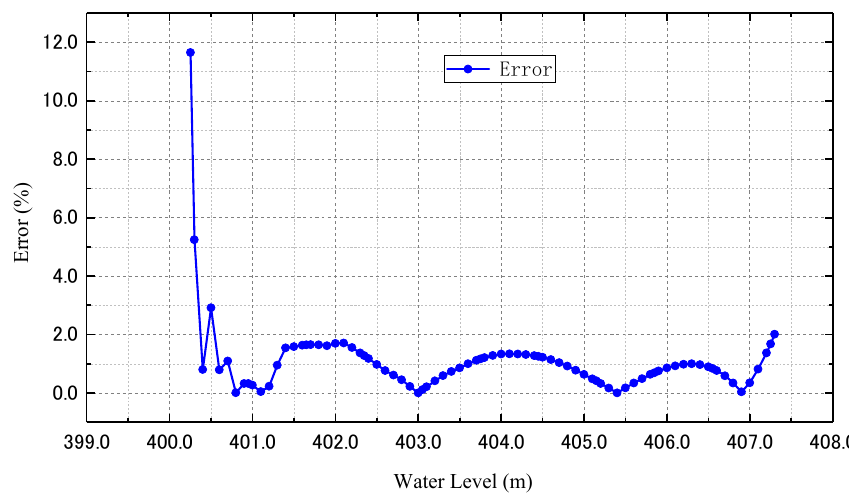
Figure 10. Figure on errors of simplified and accurate algorithms in the pressure flow stage. The statistical data on calculation errors between the “simplification-fitting” algorithm and the accurate algorithm are displayed in Table 4. According to the calculation results, the average error in the simplified algorithm is +1.23%, as compared with the accurate algorithm. The error is large in the early stage. However, in light of the entire discharge process, the early stage belongs to the free discharge; therefore, the results from the simpli- fied algorithm of pressure flow in the early stage will not be adopted; thus, errors arising from this stage can be